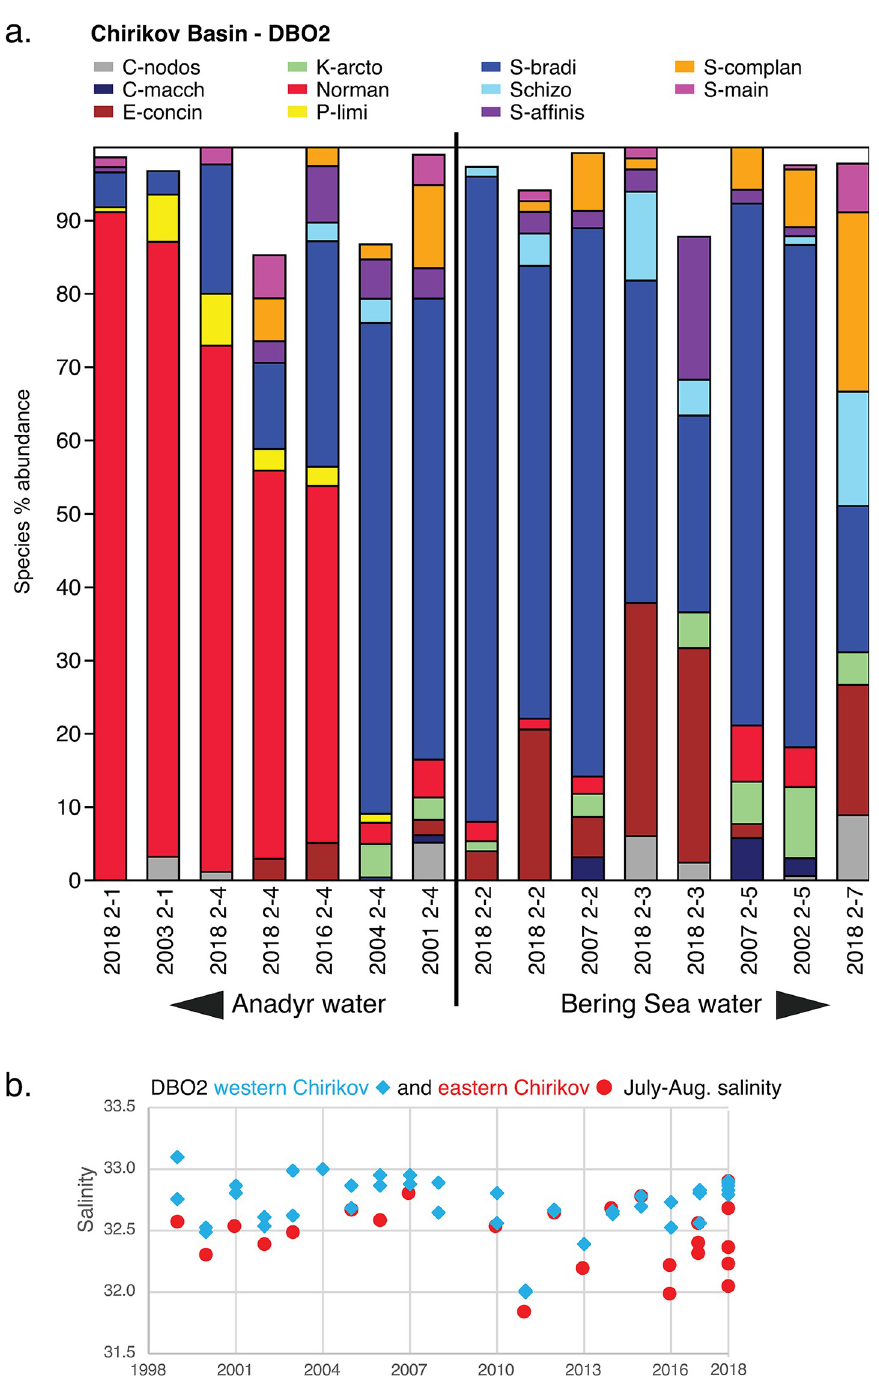
Fig 7. a. Primary species, DBO2—Chirikov Basin. Stack plot of dominant species in DBO2- Chirikov Basin region (Fig 2) in the northern Bering Sea (various years from 2001 to 2018; n = 15, 1,314 specimens with � 30 specimens/ sample). The 11 species presented in the stack plot comprise 98% of the biofacies in this ecoregion. (Note the boundary between Anadyr water on the western side of Chirikov Basin and Bering Sea Water on the eastern side is generalized in this graphic.). b. Summer bottom water salinity at western and eastern DBO2—Chirikov Basin sampling sites. Time series plot of summer bottom salinity at sampling stations on the western and eastern side of the Chirikov Basin (Sources: Grebmeier and Cooper, 2014a [61]; Okkonen, 2013 [62]; and recent expedition data (2014–2018) taken aboard USCGS Healy and CCGS Sir Wilfrid Laurier archived at the Arctic Data Center [58]).